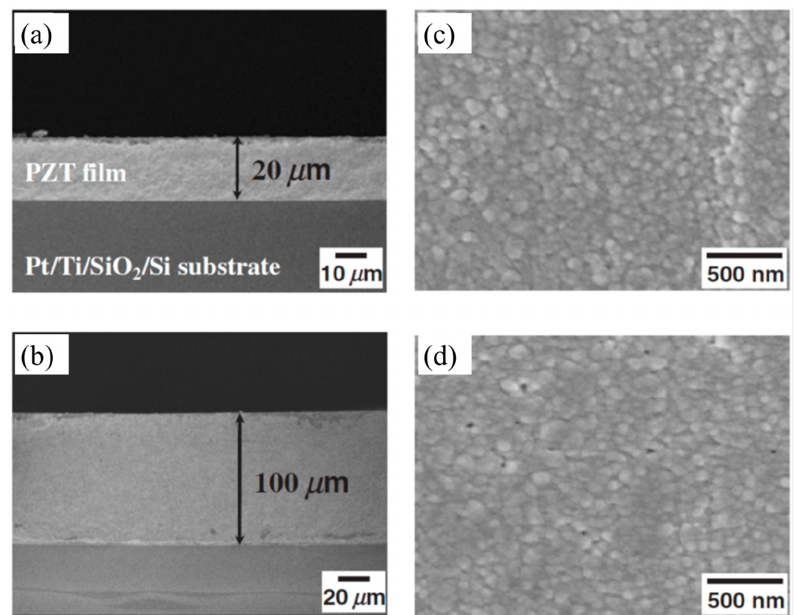
Figure 6. Field Emission Scanning Electron Microscope images of PZT thick films deposited from Figure6. FieldEmissionScanningElectronMicroscopeimagesofPZTthickfilmsdepositedfrompowder powder mixed with polyvinylidene fluoride (PVDF). ( a,b ), Cross-sectional and ( c,d ) surface mixed with polyvinylidene fluoride (PVDF). ( a , b ), Cross-sectional and ( c , d ) surface microstructure microstructure images of PZT thick films [22]. © Copyright 2008, Jpn. J. Appl. Phys. images of PZT thick films [22]. © Copyright 2008, Jpn. J. Appl. Phys.